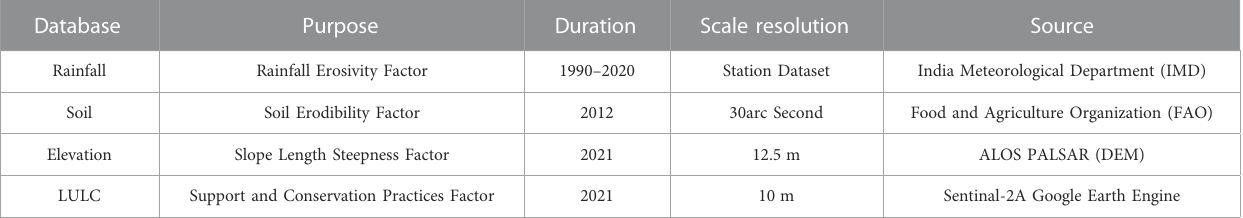
TABLE 1 The database used for estimating soil loss using the RUSLE